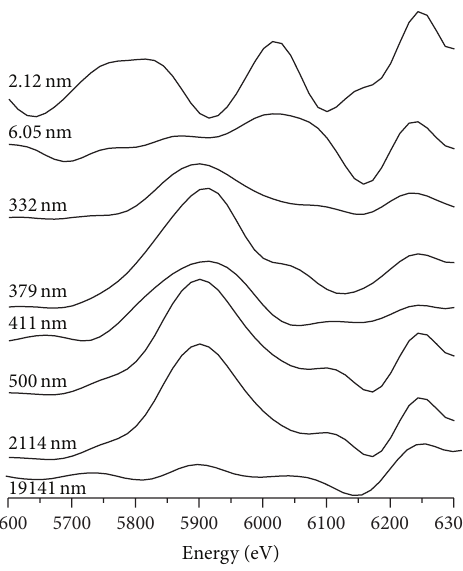
Figure 5: Residuals between experimental Raman spectra and the data fitting as a function of the studied depth for sample